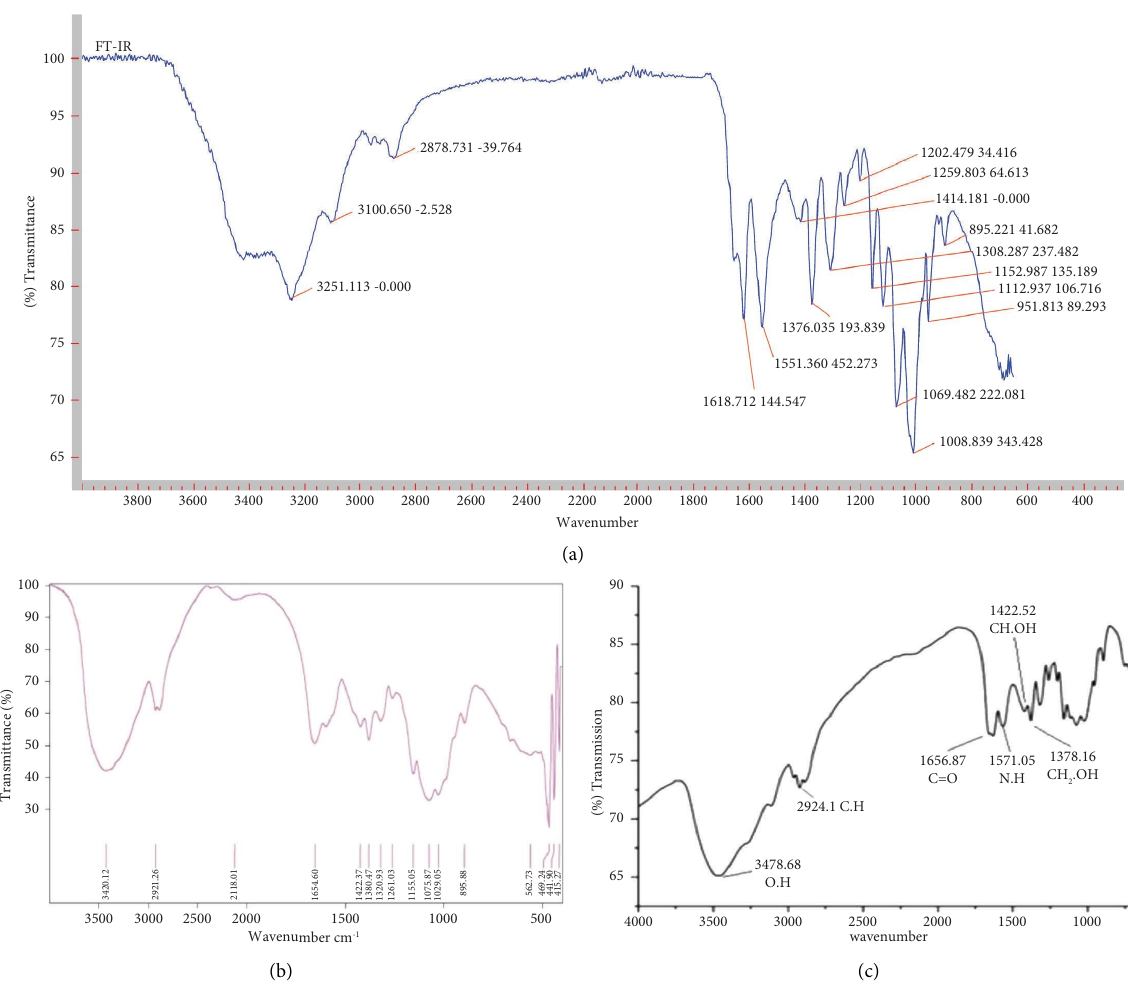
Figure 2: (a) FT-IR spectra of prepared chitosan. (b) FT-IR spectra of commercial chitosan [24]. (c) FT-IR spectra of synthesized chitosan [25].